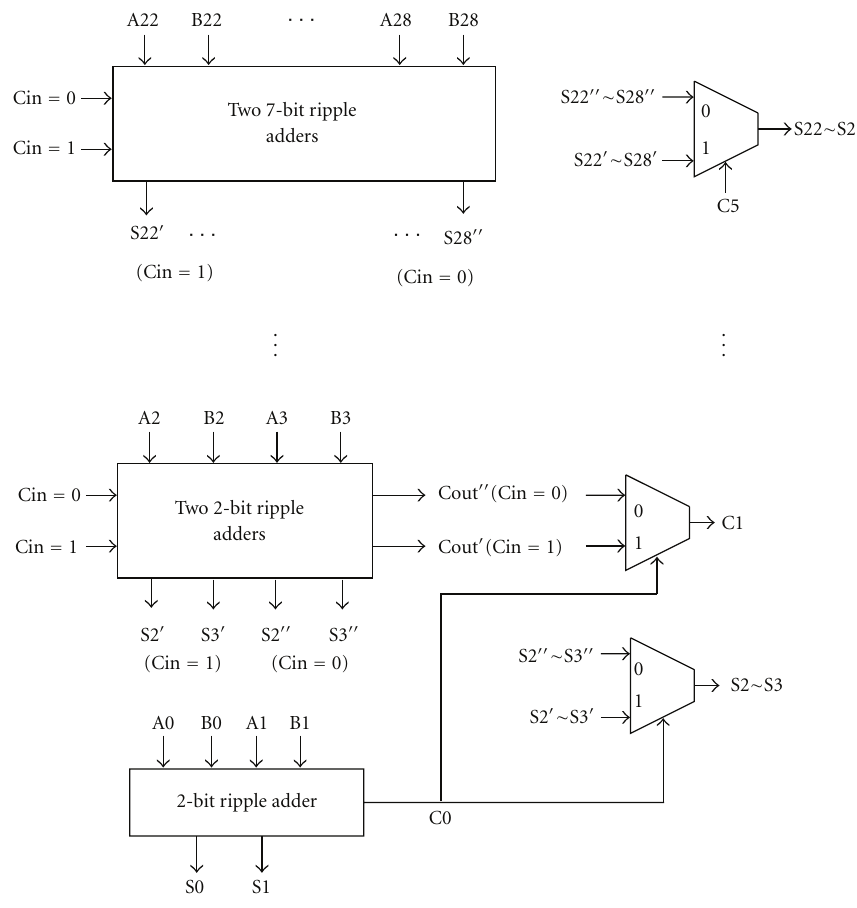
Figure 10: A modified 29-bit carry-select